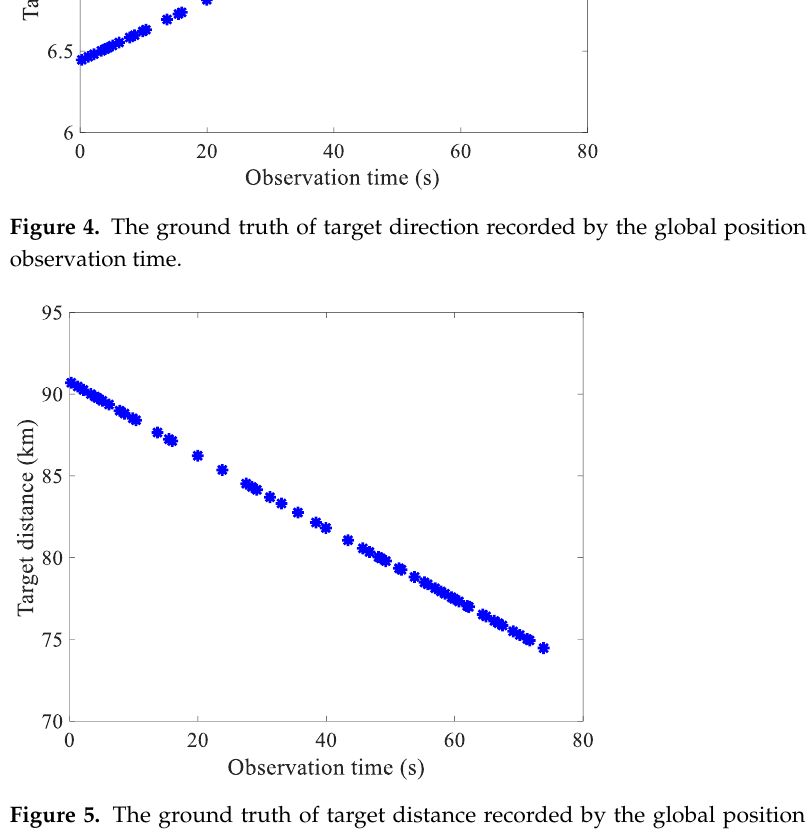
Figure 5. The ground truth of target distance recorded by the global position system across the observation